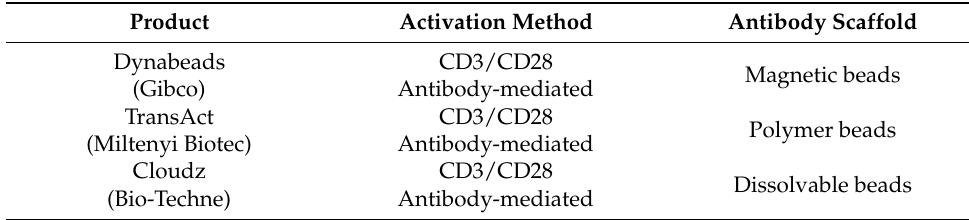
Table 2. GMP compliant T cell activation